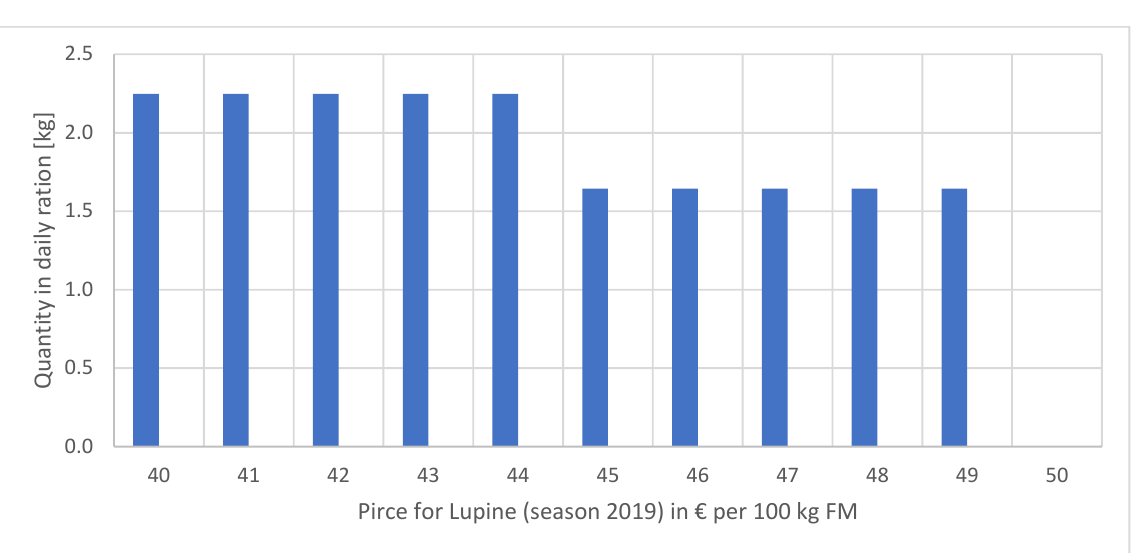
Figure 1. Substitution value and usage level.